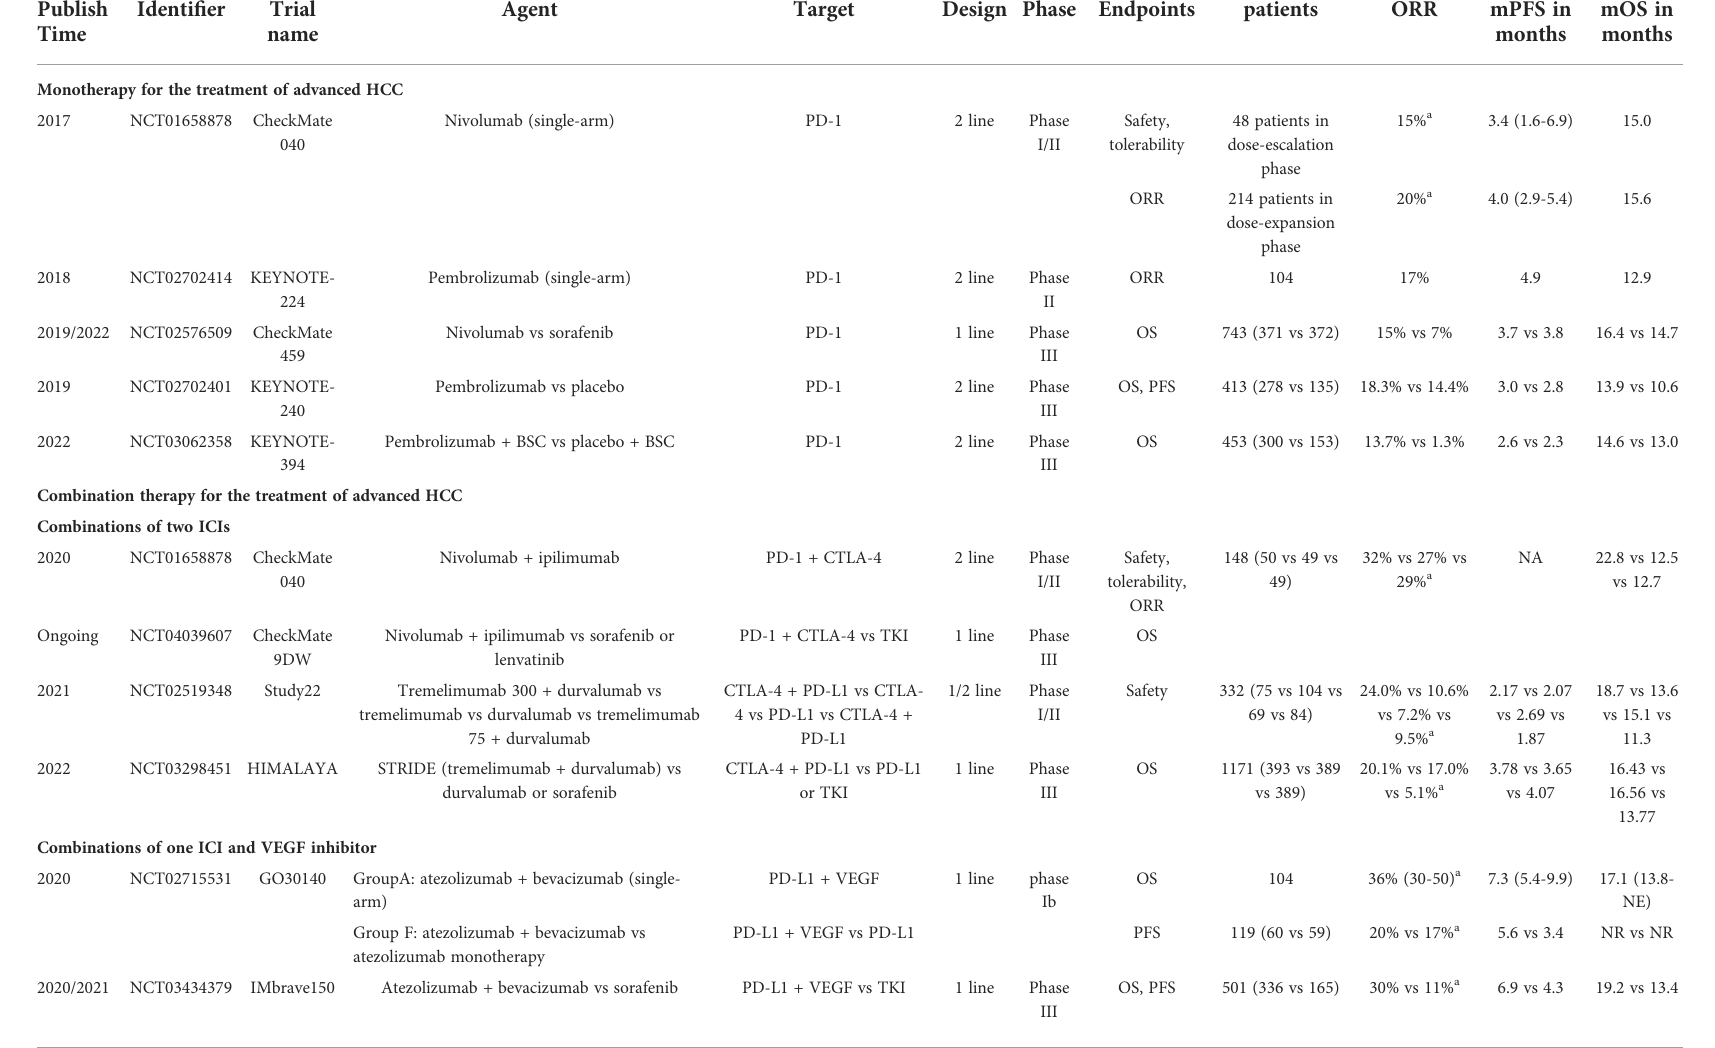
TABLE 1 Representative clinical trials for the systemic treatment of